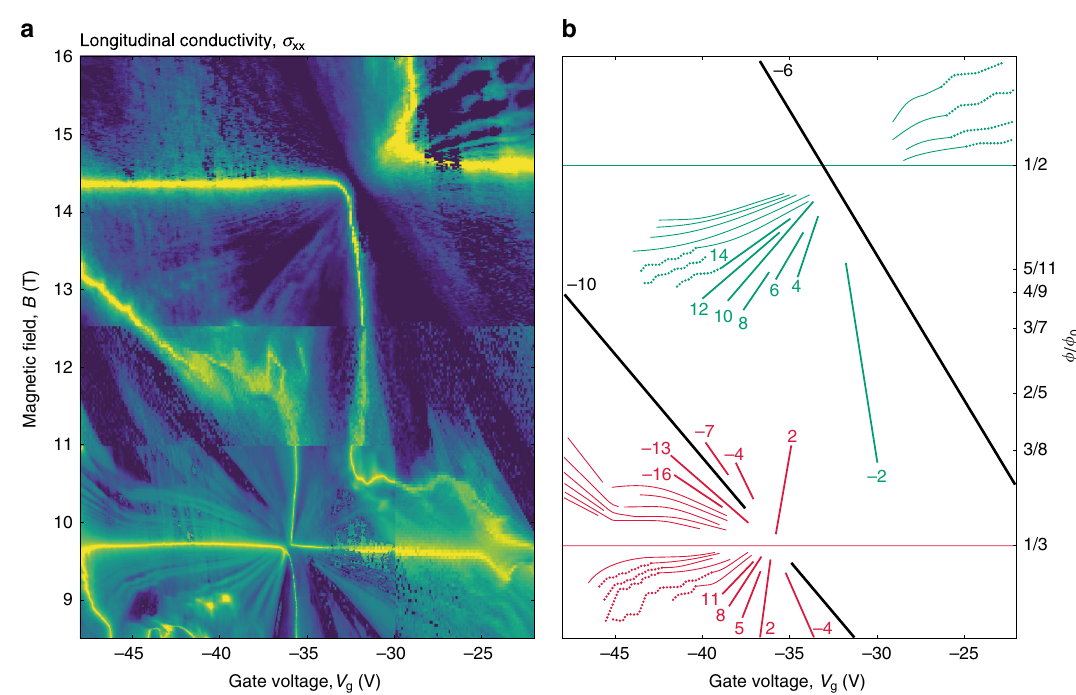
Fig. 4 Anomalous behavior of Landau levels in BZ minibands. a High-resolution σ xx ( V g , B ) for the hole-doped region marked in Fig. 1c (device D1). The measurements below B = 12.5 T were carried out at 10 mK, and at 250 mK in the fi elds above. B was applied in steps of 16 and 40 mT above and below 12.5 T, respectively, except for the low left corner where the data were acquired at higher resolution of 10 mT (seen as discontinuities in the contrast). Log scale: indigo (310 nS) to yellow (0.3 mS). b Schematics for the conductance minima found in ( a ). The same color coding as in Fig. 3b. The solid lines indicate LLs evolving as expected, linearly in B and V g . The thin curves indicate the anomalous bending whereas the dotted curves show the staircase-like evolution observed for some LLs. All the anomalous features were highly reproducible and, for example, did not depend on the step size in B